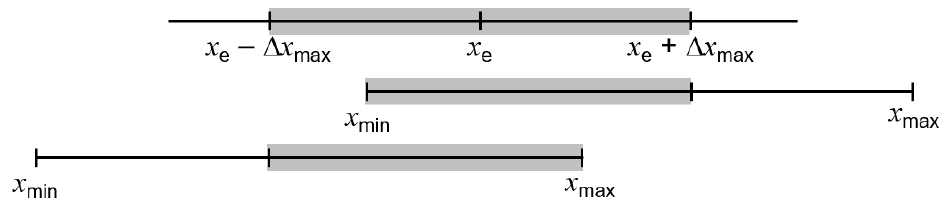
Figure 1. Possible ranges of design change in the optimality criteria method.